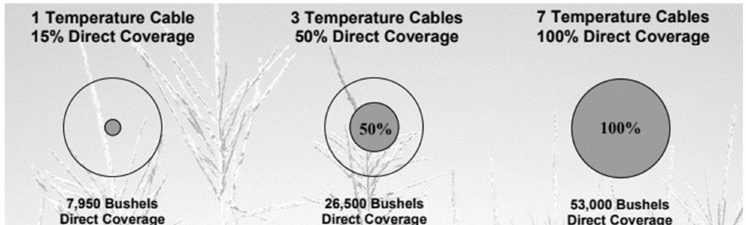
Figure 2. Three recommended temperature cable configurations and claimed grain mass coverage for a 14.6 m (48 ft) diameter, 10.1 m (33 ft) eave height, and 14.6 m (48 ft) peak height grain silo rated to hold 1346 MT (53,000 bu) of peaked